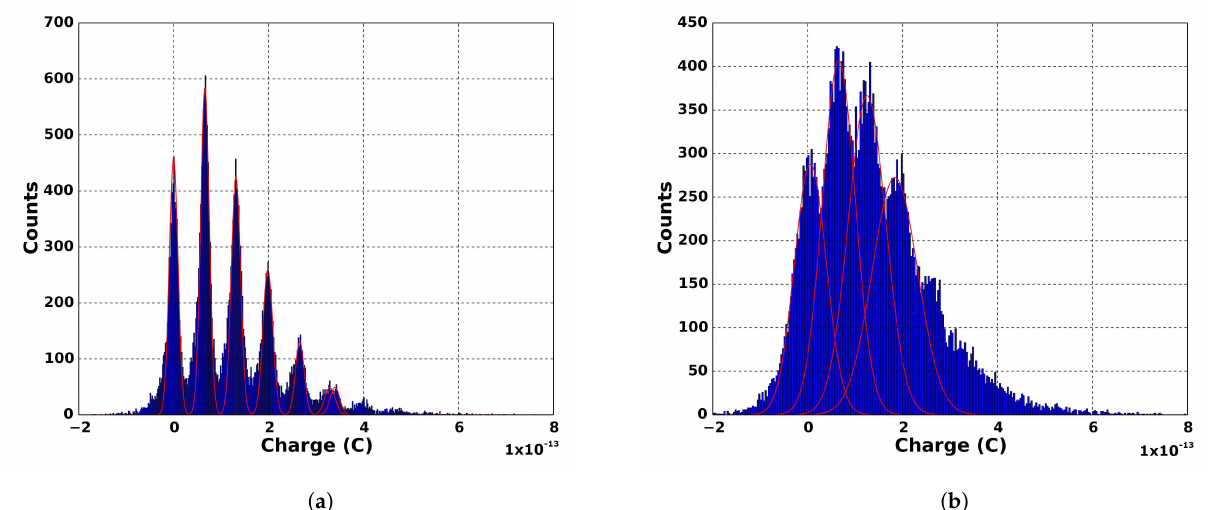
Figure 14. Charge distribution of the summation circuit with PZ cancellation using the Hamamatsu SiPM S13360 − 6050CS at 6V of over − voltage. ( a ) Summation of 1 channel; ( b ) Summation of 7 channels.